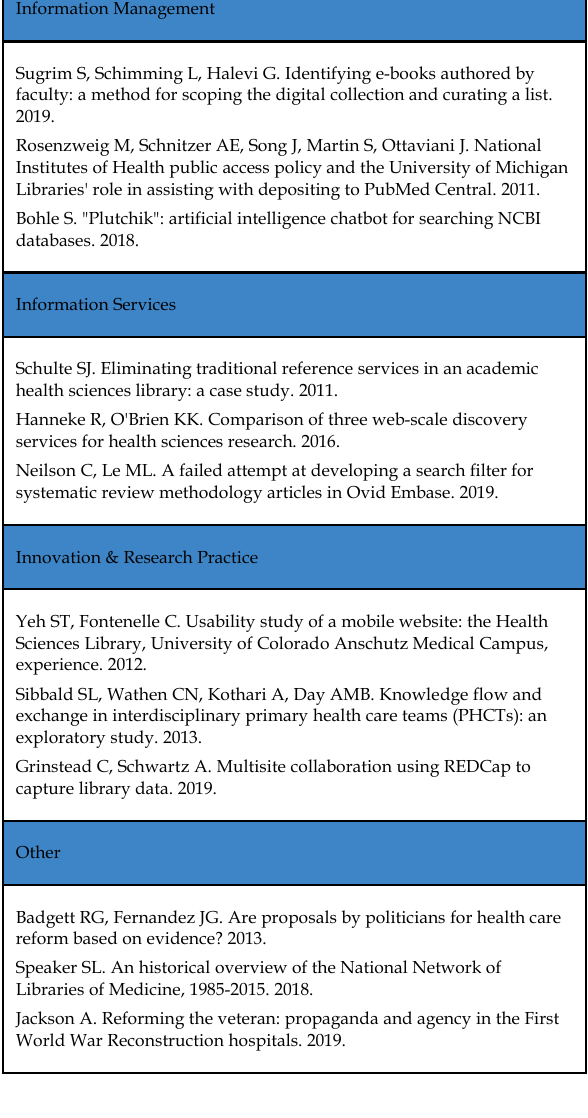
Table 1: Example articles categorized by domain hub.